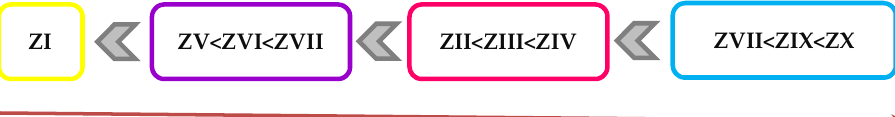
Figure 14. Relation between the quantity of calcium ions (Ca 2+ ) leached and the type of ashes used in cement–ash mortars exposed to solutions of HCl, H 2 SO 4 and HNO 3 .